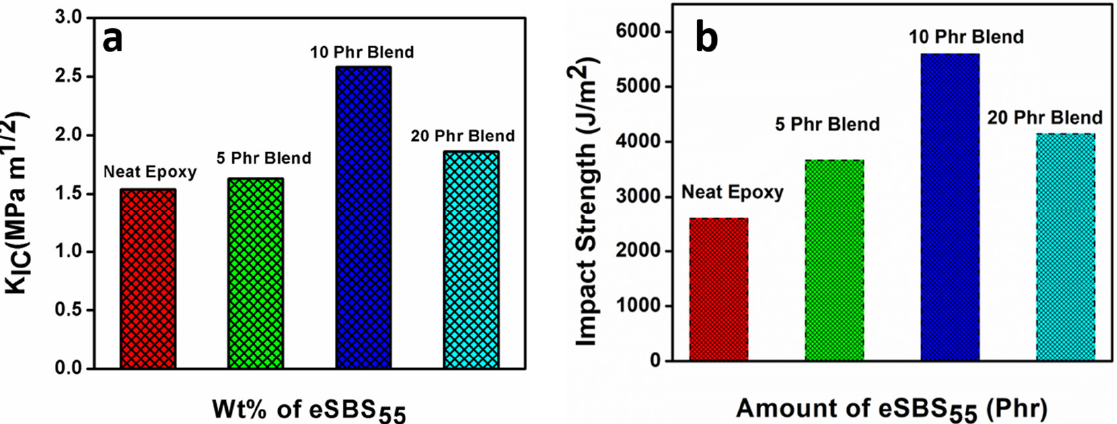
Figure 2. ( a ) Fracture toughness and ( b ) impact strength of neat epoxy and epoxy/eSBS 55 blends systems.